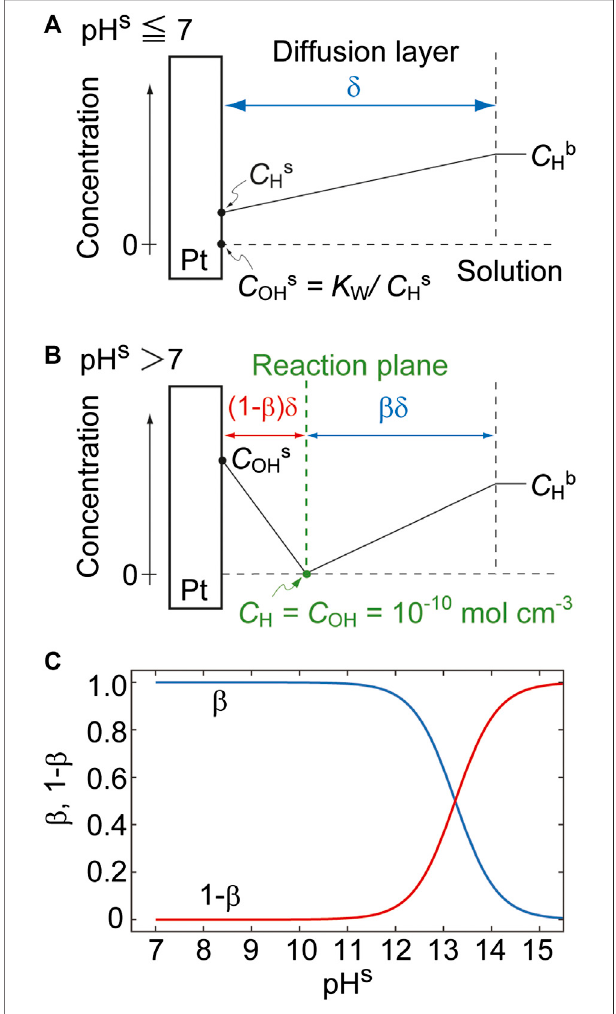
FIGURE 4 | The near-surface concentration pro fi les for (A) pH s ≤ 7 and (B) pH s > 7. (C) The effects of pH s on β and 1 − β with pH b set to 1 (i.e., C Hb (cid:2) 10 – 4 mol cm − 3 ).